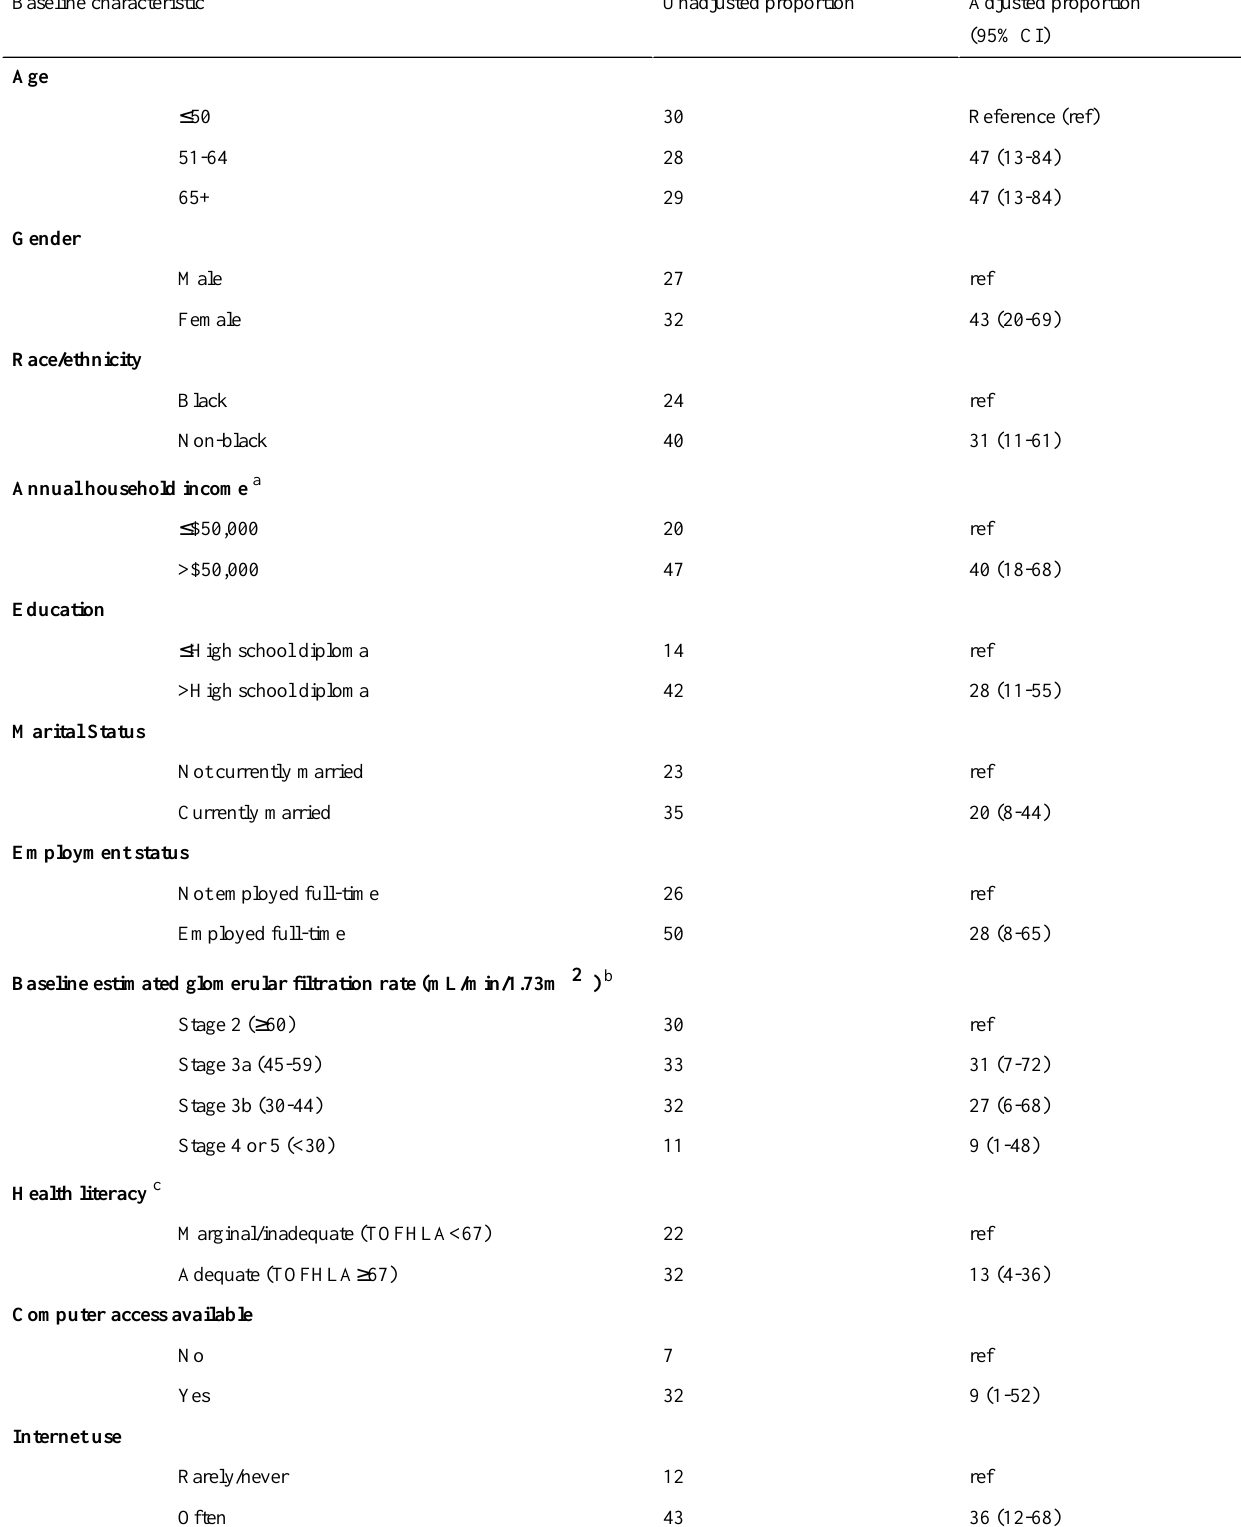
Table 3. Predictors of Safe Kidney Care website